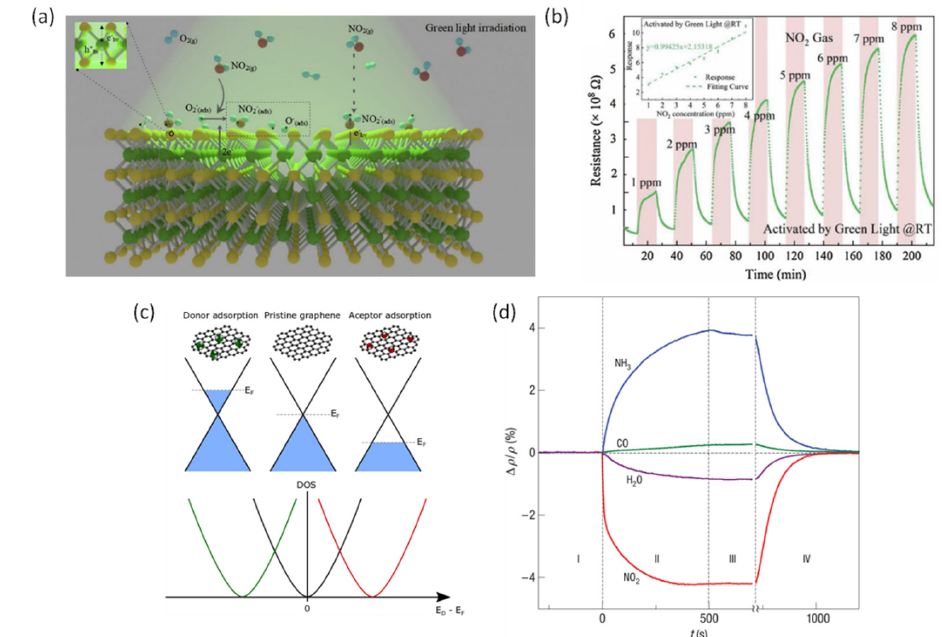
Figure 8. ( a , b ) Sensing mechanism of SnS 2 2D nanosheets towards NO 2 and response under green light illumination. Adapted with permission from [53]. Copyright by Elsevier (2020). ( c , d ) Conductometric sensing mechanism of graphene based on the variation of electronic DOS upon Fermi level variation due to analyte adsorption doping and measured response for different analytes. Adapted with permission from [81]. Copyright by Nature Publishing group